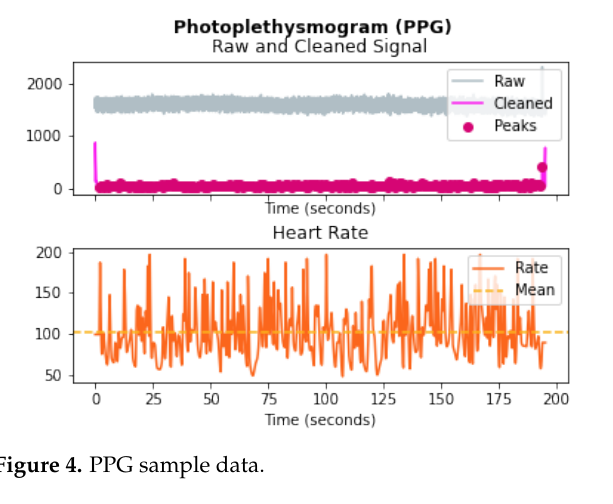
Figure 4. PPG sample data.